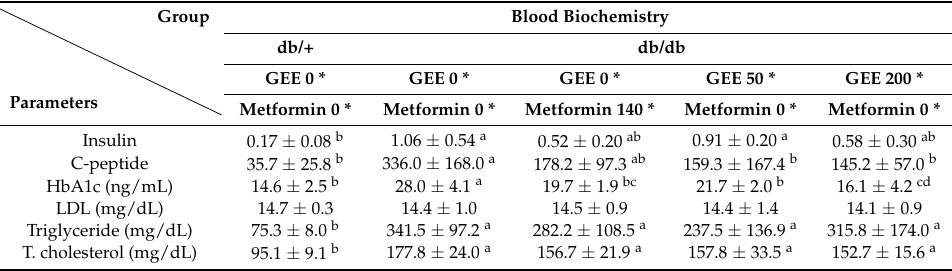
Table 3. Effect of GEE on blood biochemistry in db/db mice. LDL: low-density lipoprotein; HbA1c: hemoglobin A1c.